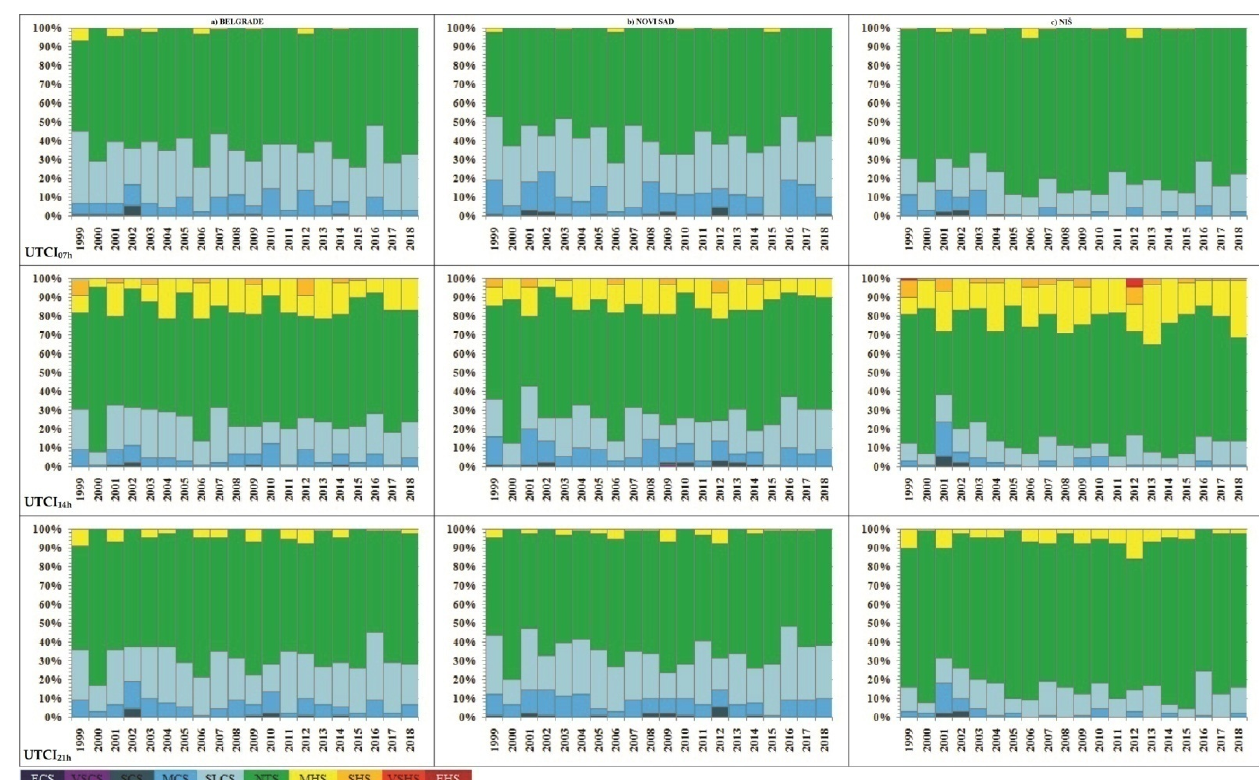
Figure 4. Frequencies of different cold and heat stress category in ( a ) Belgrade; ( b ) Novi Sad and ( c ) Niš based on UTCI 07h (first column), UTCI 14h (second column), UTCI 21h (third column) during autumn, over a period of 20 years (1999–2018).